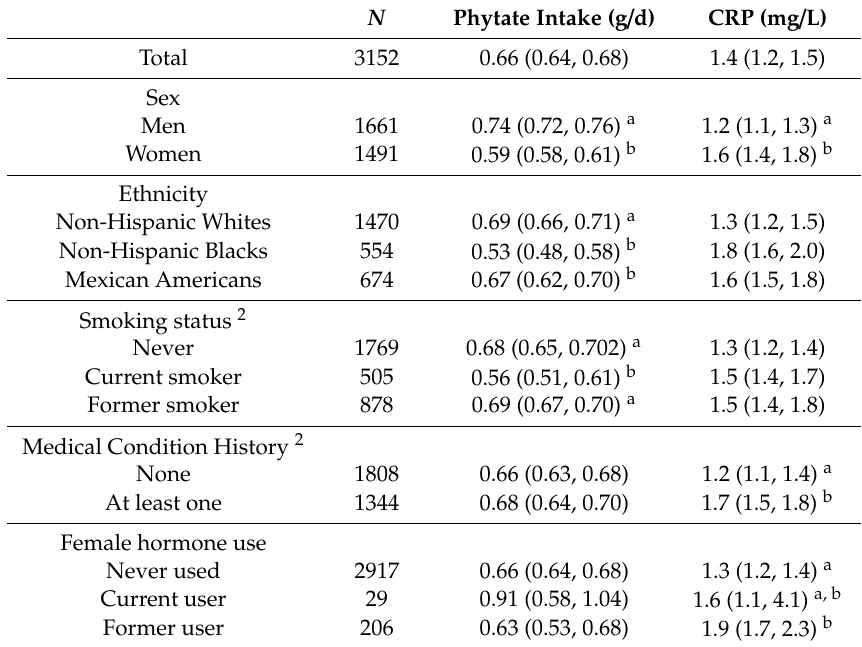
coronary heart disease, angina / angina pectoris, heart attack, stroke, cancer, and diabetes. Table 2. Phytate intake and C-reactive protein (CRP) concentration among subjects ≥ 20 years old with overweight or obesity as per the NHANES of 2009 / 2010 1 .